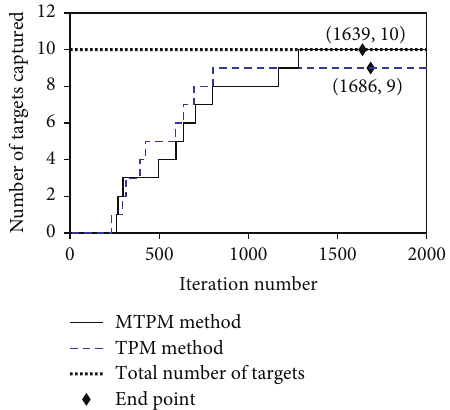
Figure 6: Comparison on the number of captured targets with the iteration number between the two methods.